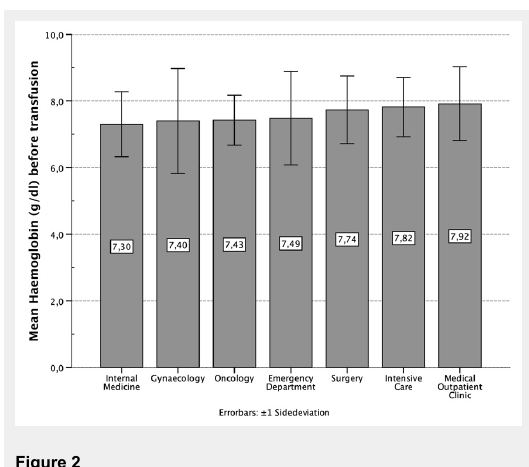
Figure 2 Mean haemoglobin (g/dl) before transfusion, distributed by